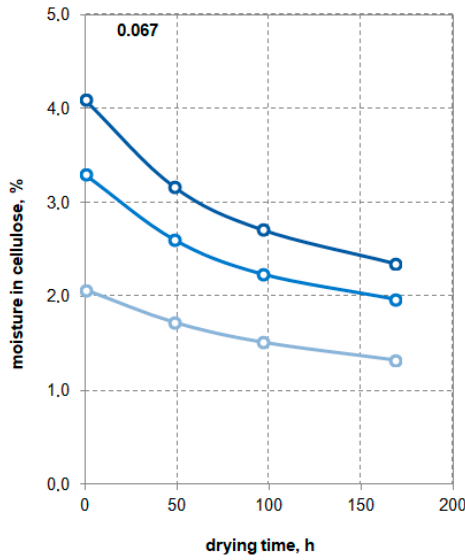
Figure 7. Water content in cellulose samples depending on drying time for three different values of initial moisture of cellulose; mass ratio of cellulose to ester 0.067, samples thickness 3 mm, temperature 85 °C; triple introduction of an ester with moisture content of 70 ppm.